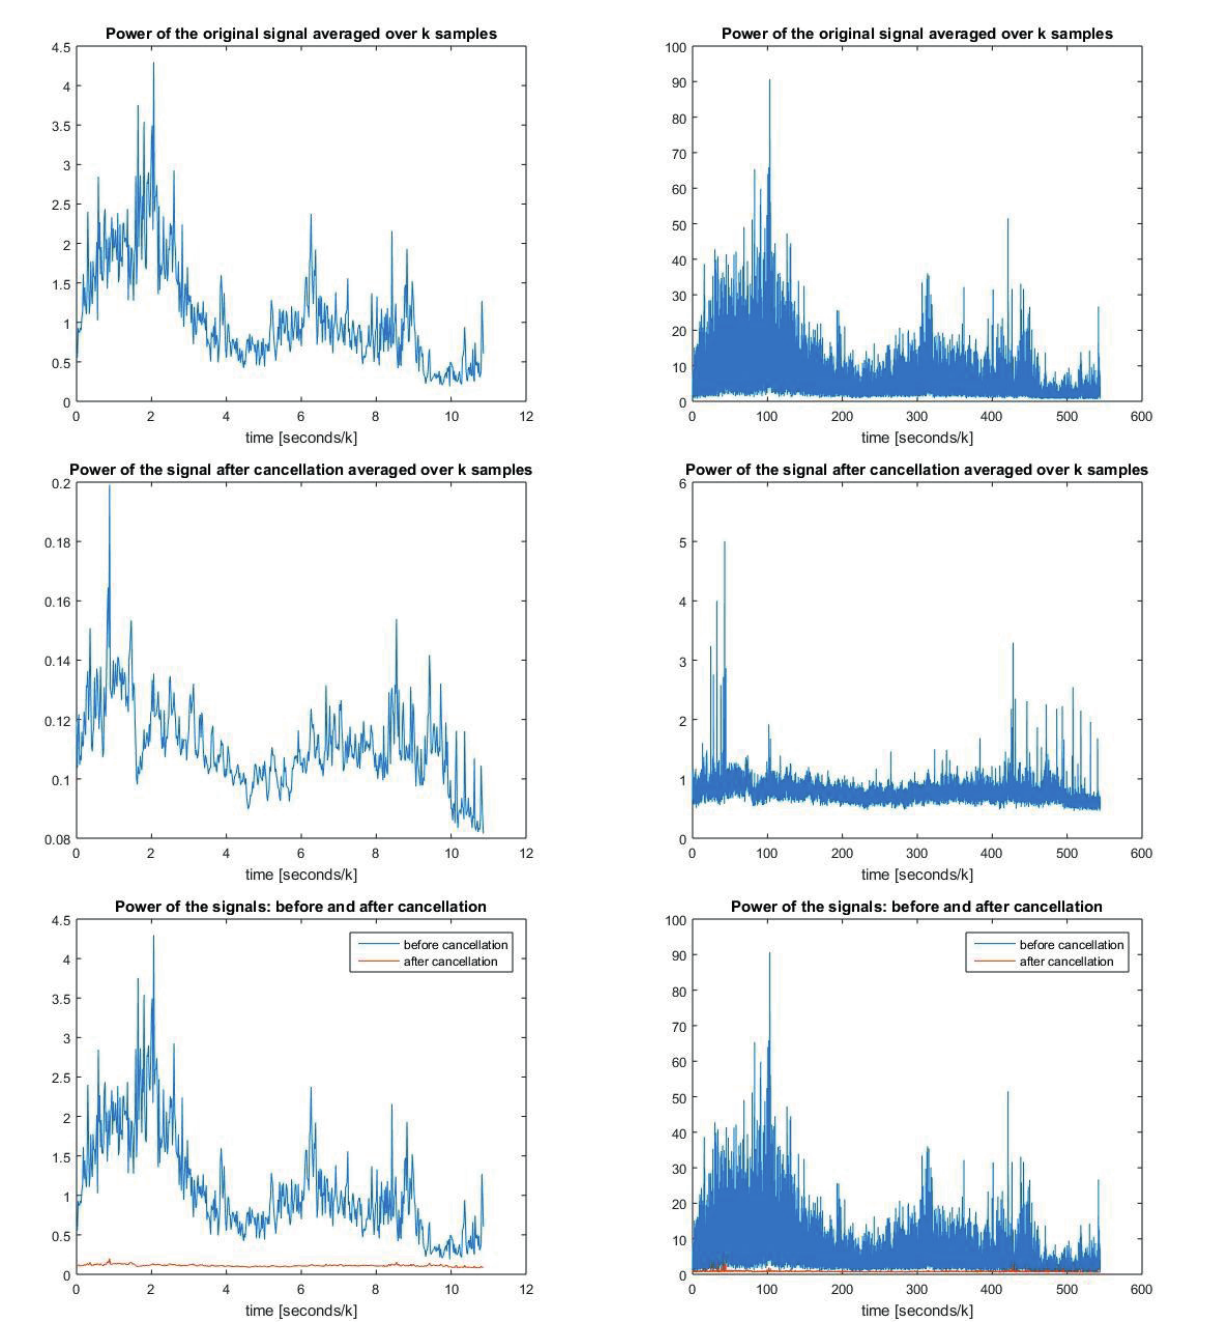
all the low frequency noise. In this case, mitigation of the residual infrasound is needed.